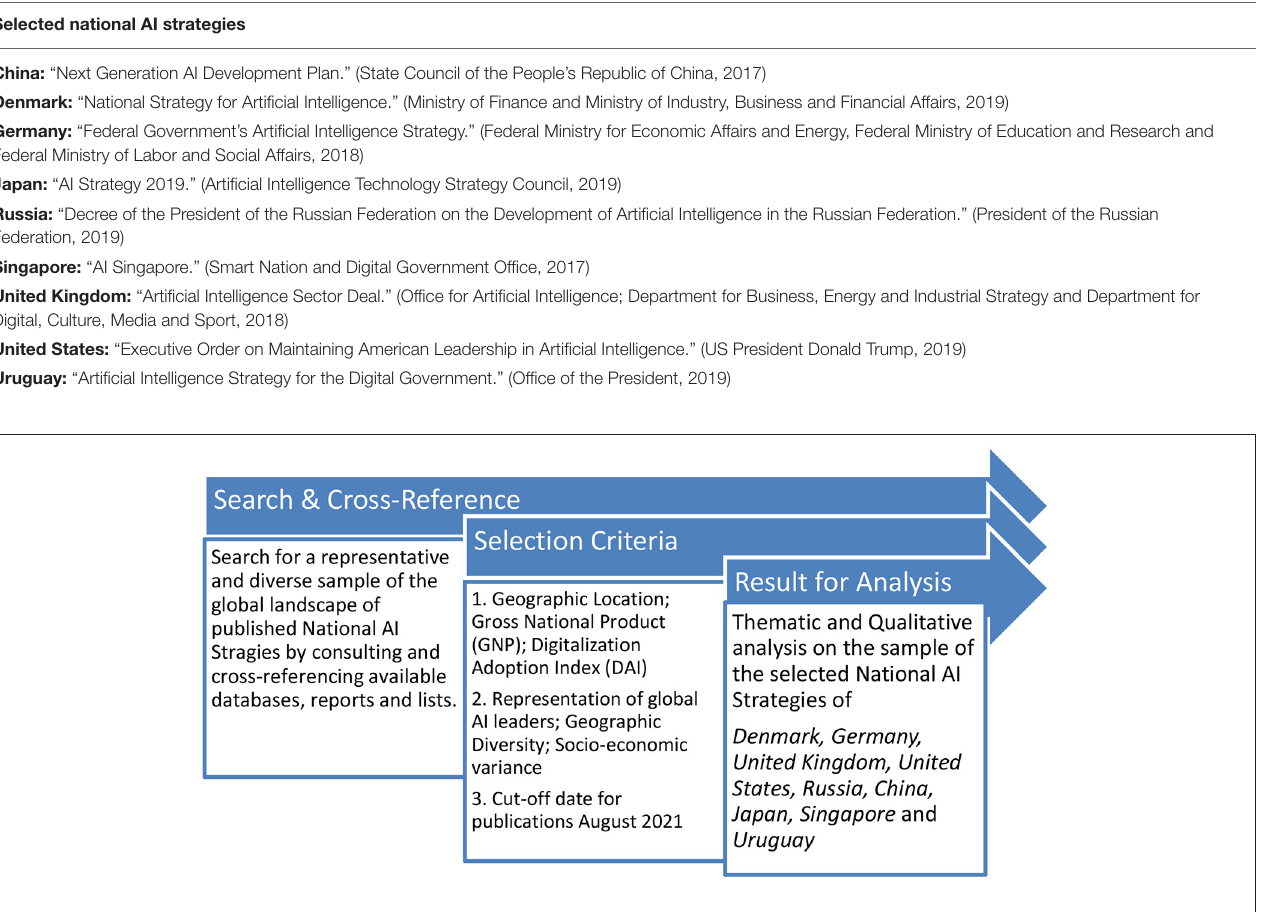
FIGURE 1 | Methodology for selecting national AI strategies for the qualitative and thematic content